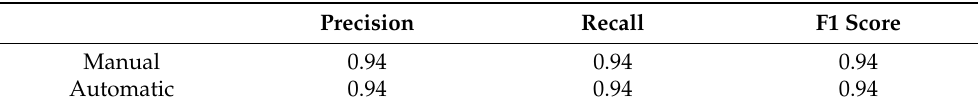
Table 7. Overall results of textural analysis of the young vs. elderly subjects for the manually and the automatically extracted CSA texture.